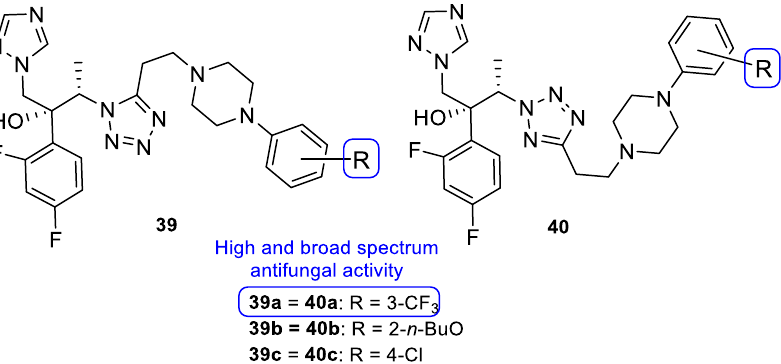
Figure 22. Chemical structures of compounds 39a – c and 40a – c and SAR [102]